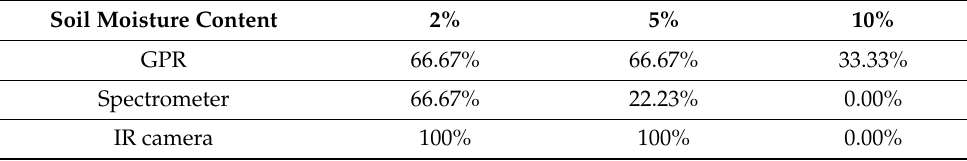
Table 8. Effect of soil moisture content on leak detection.